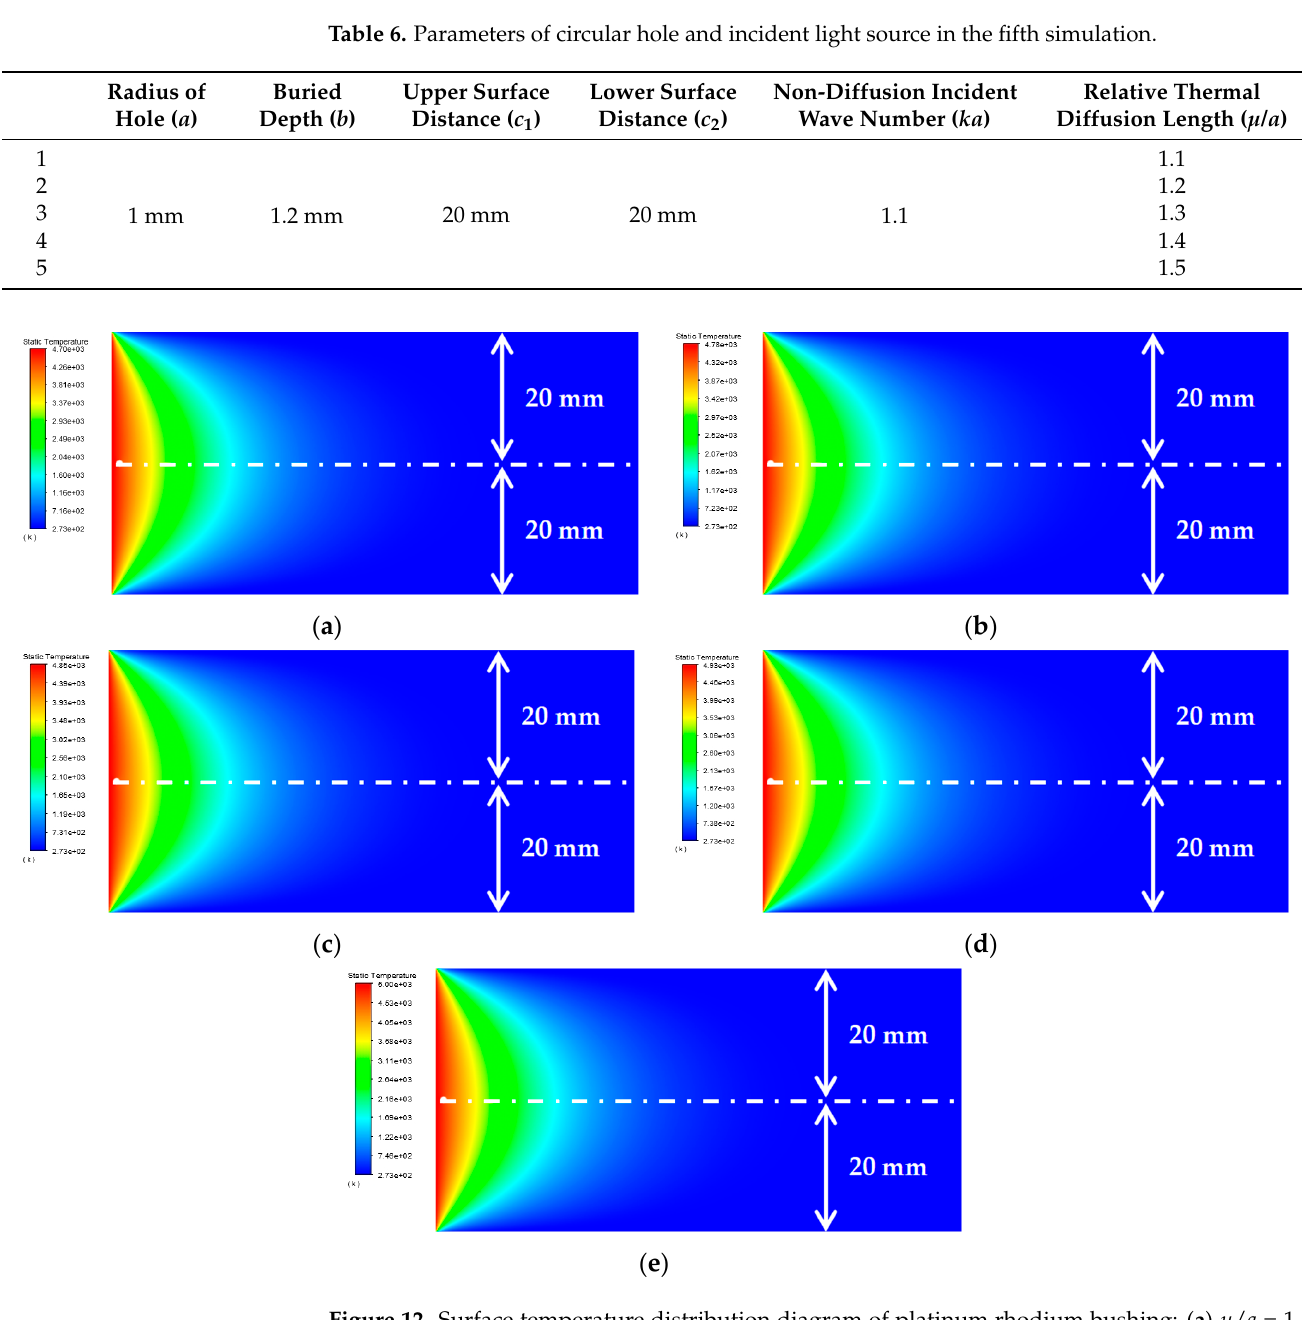
Figure 12. Surface temperature distribution diagram of platinum rhodium bushing: ( a ) µ / a = 1.1 mm; ( b ) µ / a = 1.2 mm; ( c ) µ / a = 1.3 mm; ( d ) µ / a = 1.4 mm; ( e ) µ / a = 1.5 mm.